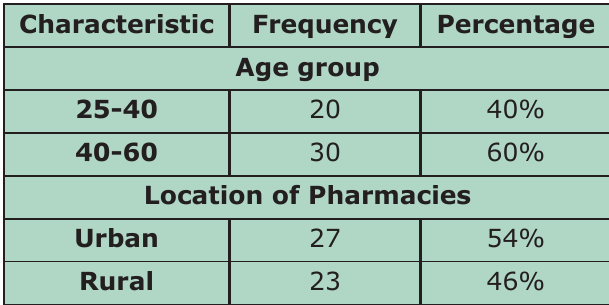
Table-I: Demographic data of